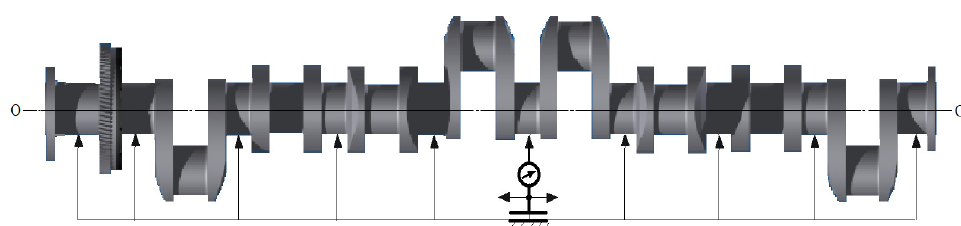
Figure 11. Adopted measurement strategy.